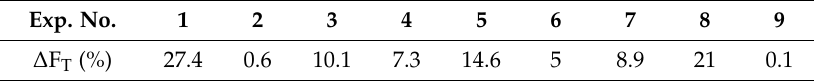
Table 12. Estimation of error of cutting force determined with average ratio method.